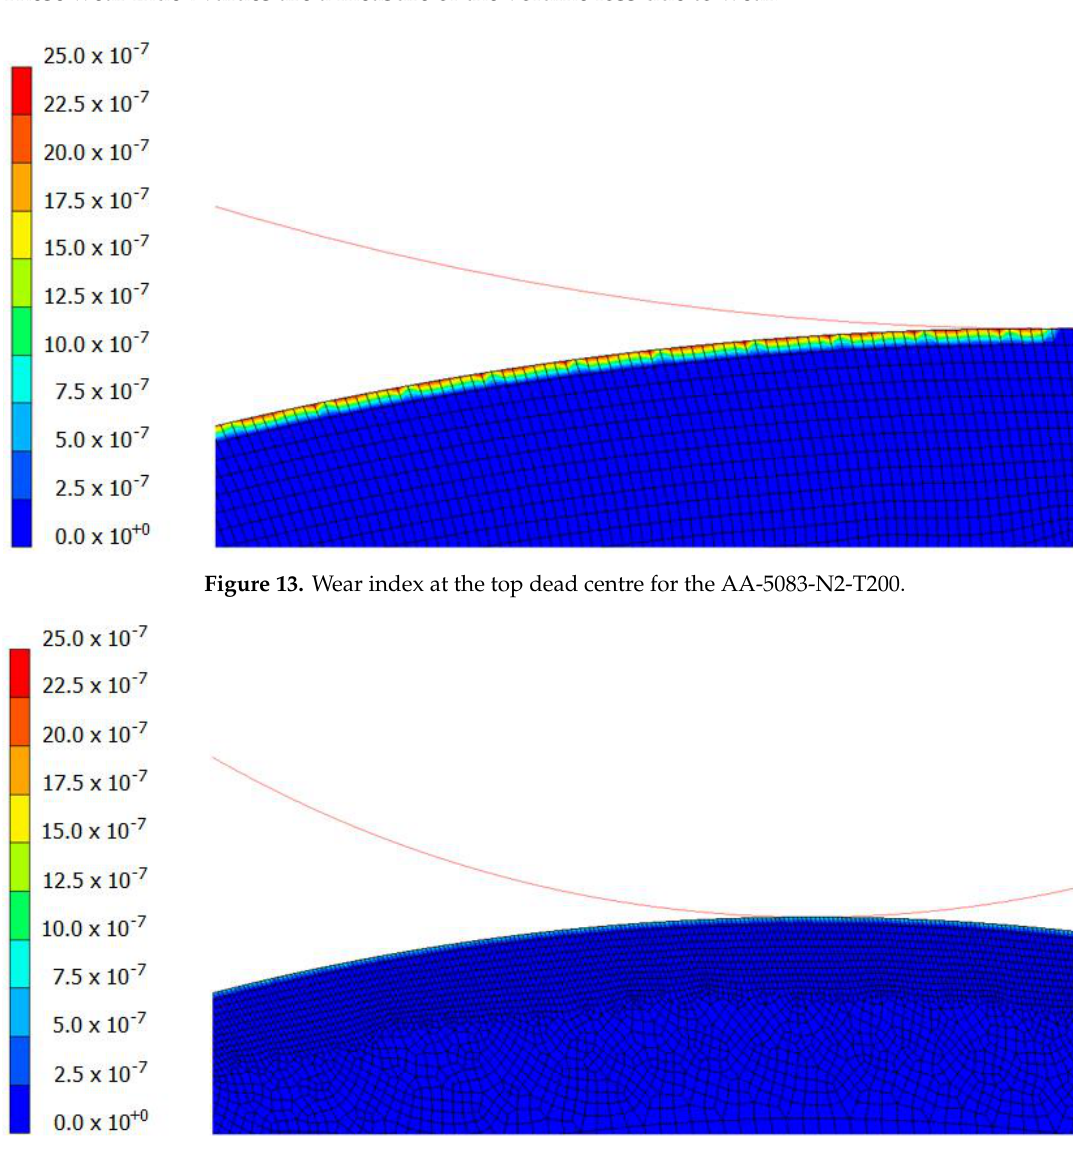
Figure 12. Effective plastic strain values of cam after the forging process with AA-5083-N0 as a starting material (most unfavourable study case) ( a ) where the first plane of cut (in red) is a cross- section plane located at the middle of the width of the cam and ( b ) the second plane of cut (in red) is a longitudinal plane located at the middle of the height of the cam.